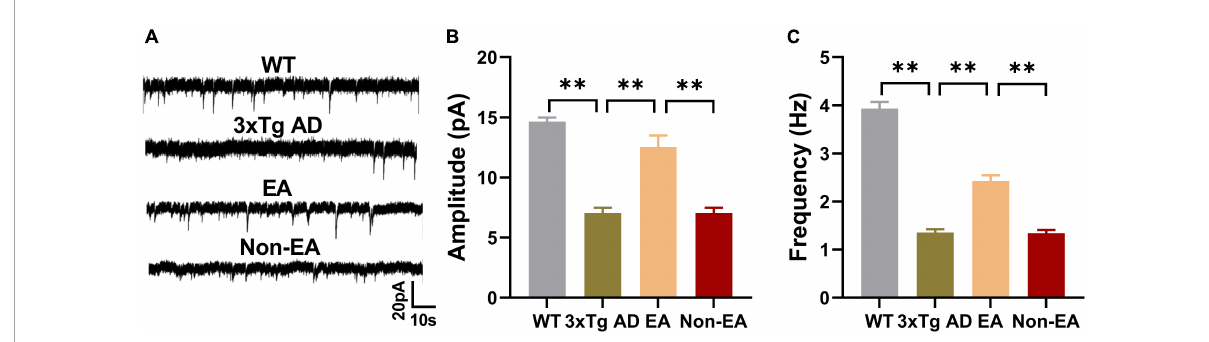
FIGURE4 Effects of the EA-treatment on hippocampal synaptic neurotransmission. (A) Representative sEPSC traces of hippocampal CA1 from all mice by whole-cell voltage-clamp recording ( n = 5 in each group). (B) The amplitude of sEPSC, and (C) the frequency of spontaneous firing of hippocampal CA1 were analyzed. Data are presented as the mean ± SEM. ** P <